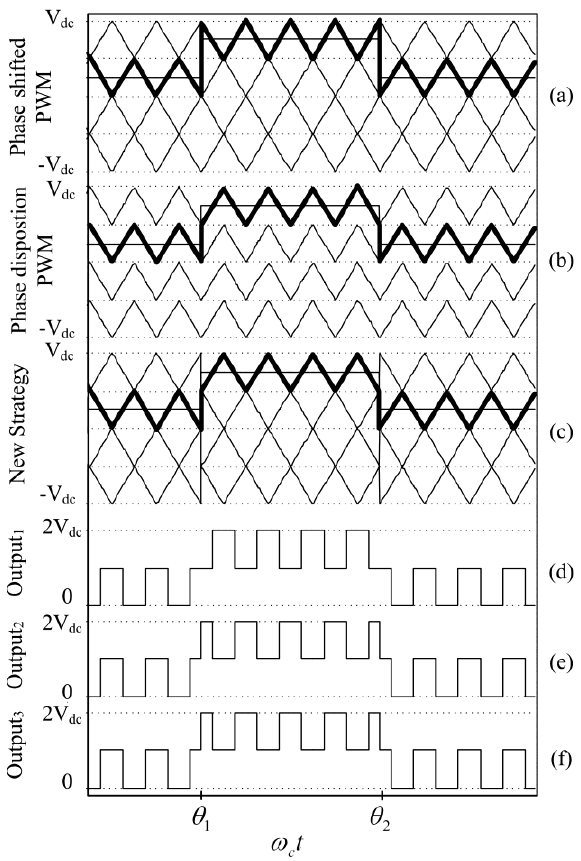
Figure 1. Modulation strategies and the corresponding output voltages: ( a ) phase-shifted pulse width modulation (PS-PWM) and phase disposition pulse width modulation (PS-PWM); ( b ) PD-PWM; ( c ) New strategy; ( d ) Output voltage for PS-PWM; ( e ) Output voltage for PD-PWM; ( f ) Output voltage for new strategy.